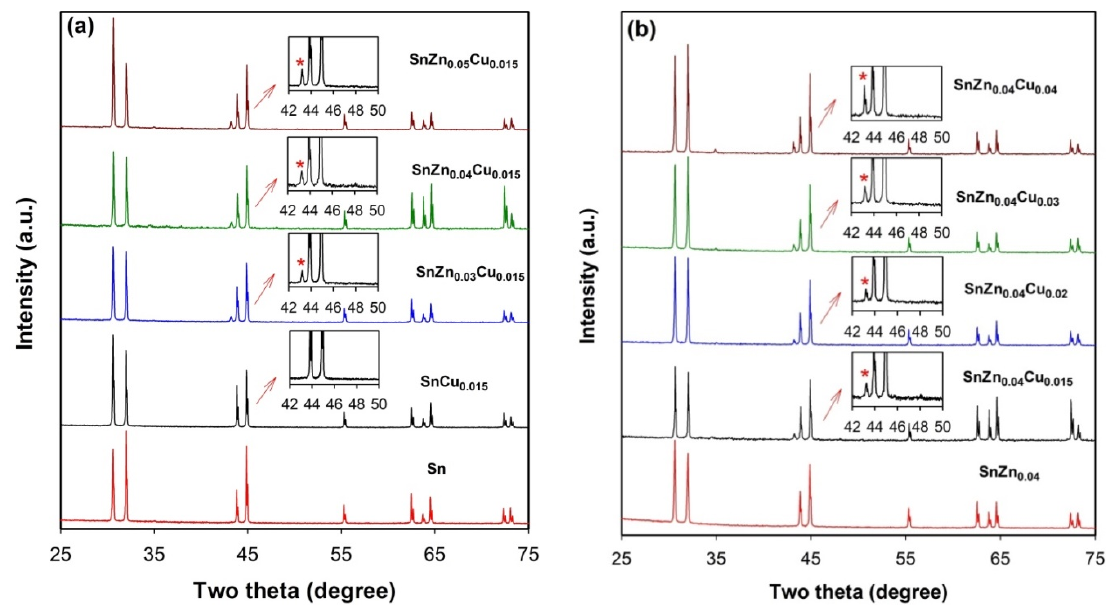
Figure 5. XRD patterns of SnZnCu microspheres with different amounts of Zn ( a ) and different amounts of Cu ( b ). XRD patterns of Sn, SnCu 0.015 , and SnZn 0.04 microspheres are also shown for comparison.